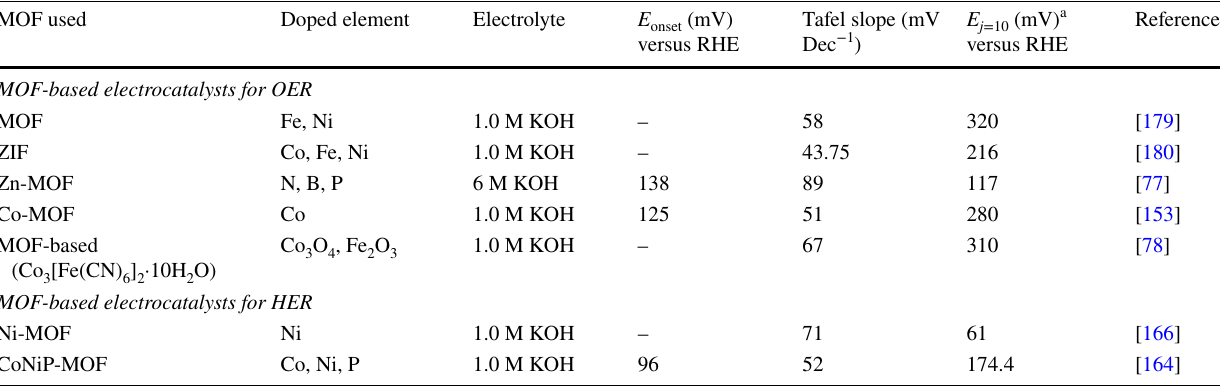
a : E j = 10 for overpotential required for the current density of 10 mA cm